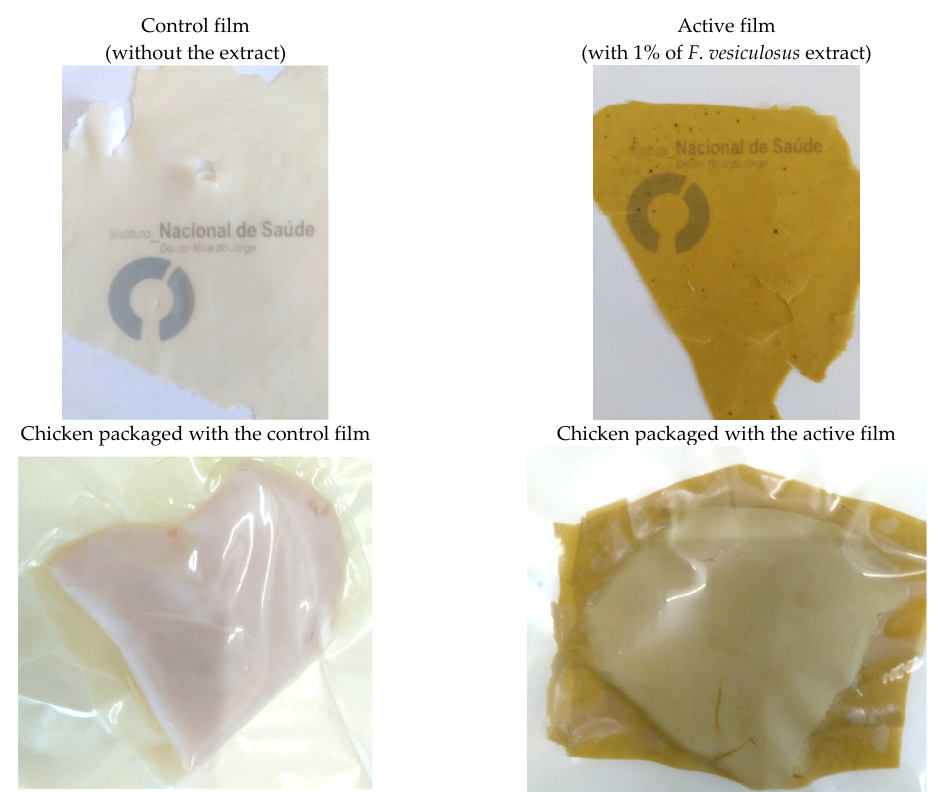
Figure 1. Control film ( left ) and active film with 1% of F. vesiculosus extract ( right ).